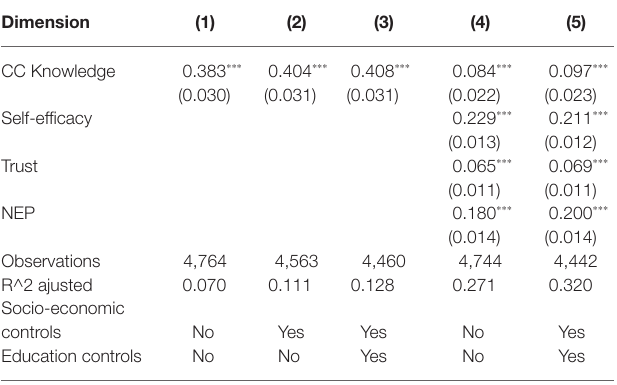
TABLE 4 | Results of the OLS model for Colombia. Dimension